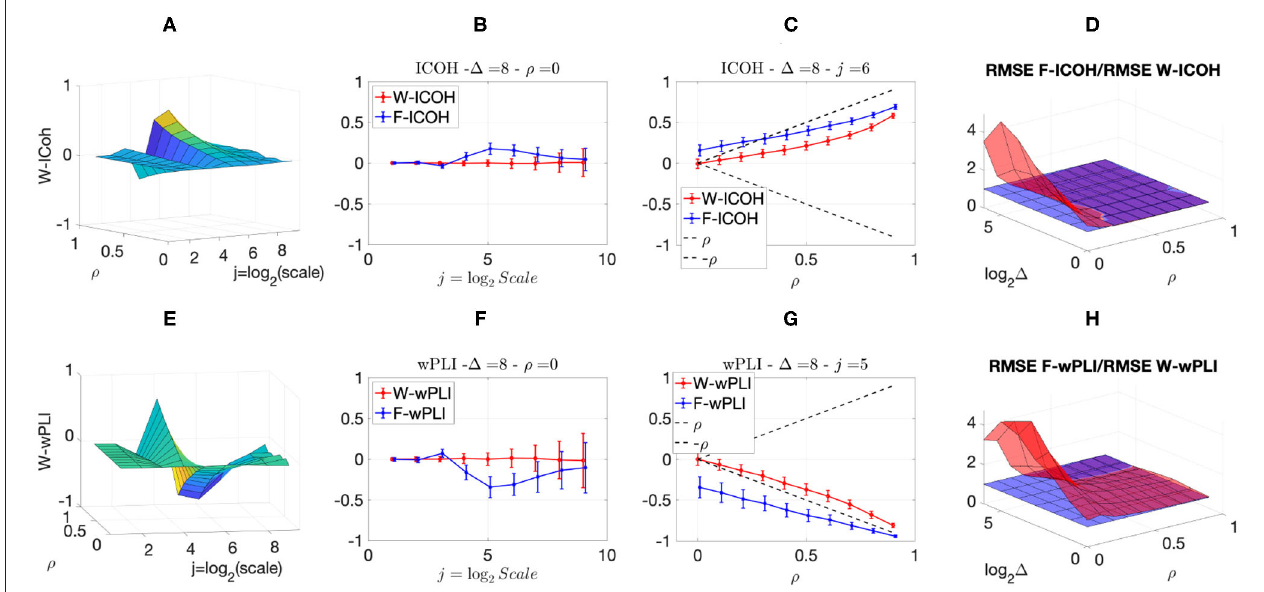
FIGURE 5 | Complex Wavelet-based connectivity on synthetic bivariate fractional Gaussian noise with correlation and delay, and additive trends. Top row: W-ICOH results. Bottom row: W-wPLI results. From left to right: W-ICOH (A) and W-wPLI (E) as functions of octaves j and correlation coefficient ρ , W-ICOH (B) and W-wPLI (F) as functions of octaves j , for a given ρ , and W-ICOH (C) and W-wPLI (G) as functions of ρ for given octaves j . The ratio of the RMSE of F-ICOH to the RMSE of W-ICOH (D) and the ratio of the RMSE of F-wPLI to the RMSE of W-wPLI (H) , averaged across scales 3 ≤ j ≤ 7 and color-coded in red as functions of delay 1 and correlation coefficient ρ . A ratio greater than the value of 1 (made explicit to ease comparisons by horizontal blue plans) indicates poorer performance for Fourier-based estimates compared to wavelet-based ones. Synthetic data consists of bivariate fGn with H = 0.8 and fBm with H = 0.2.